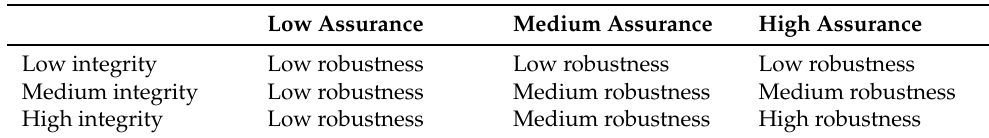
Table 5. Determination of robustness level [20].